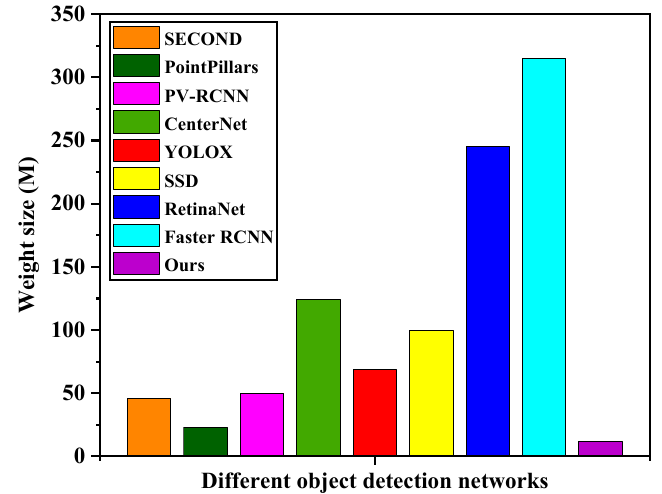
Figure 18. Comparison of network weight size of different object detection algorithms.